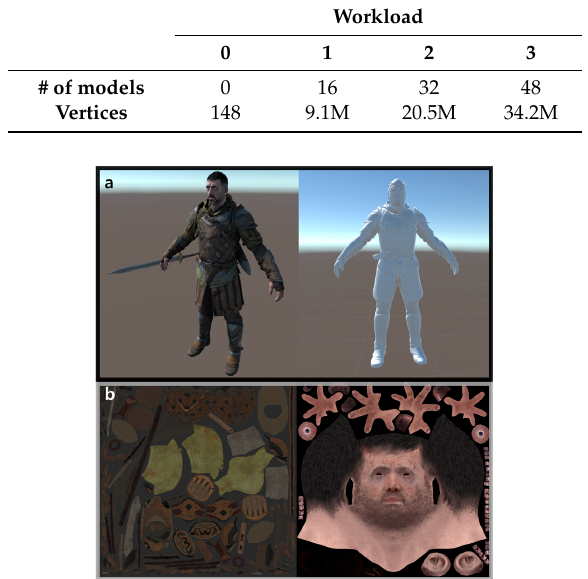
Figure 16. ( a ) A model with a high number of polygons used in the experiment and ( b ) textures of the model.